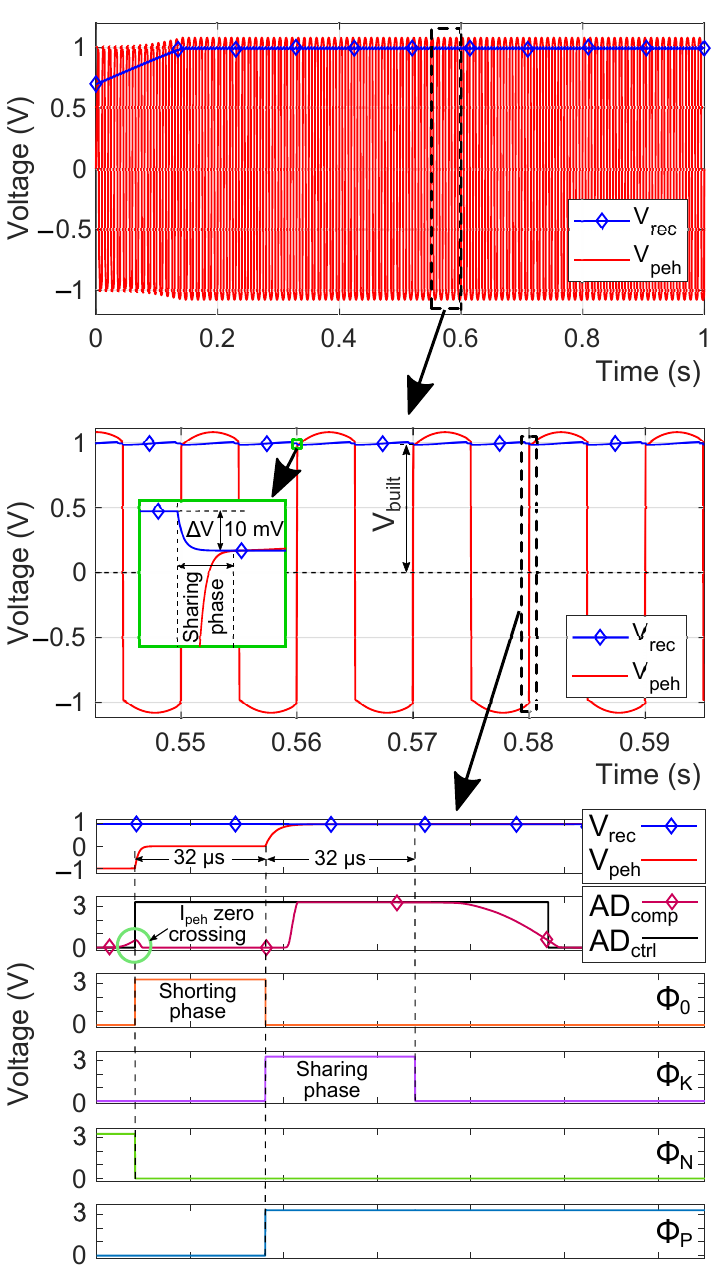
Figure 11. Transistor-level transient simulation results: V peh , V rec and control